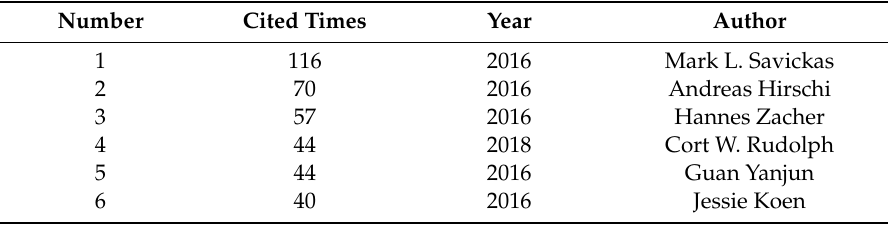
Table 1. List of cited frequencies of career adaptability research authors (top